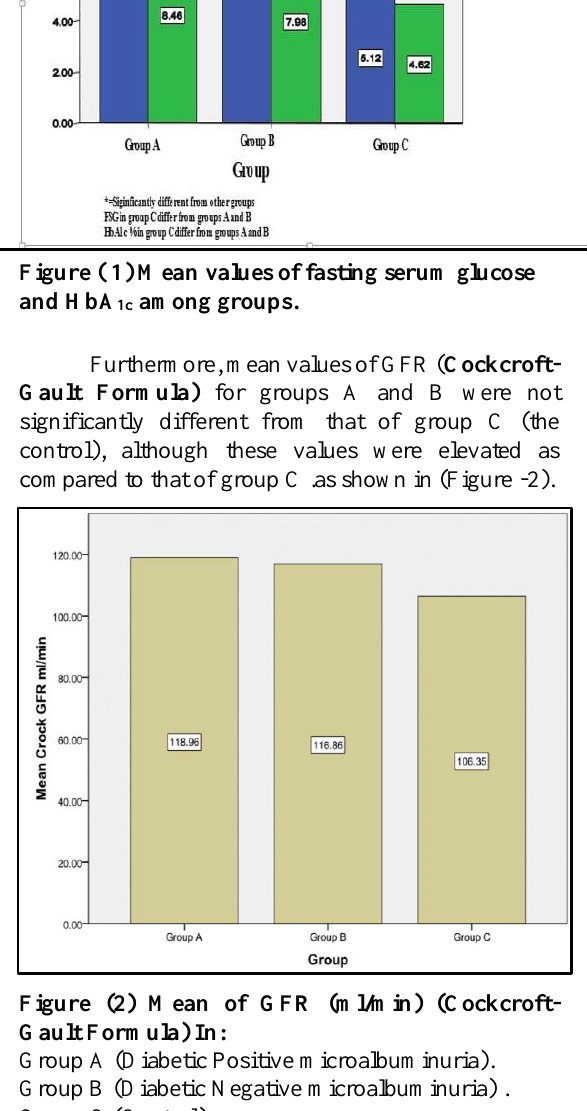
Figure (4) Mean values of serum aldosterone